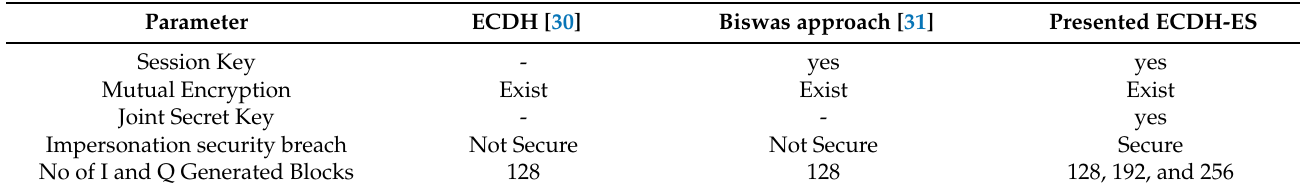
Table 3. Comparison of the proposed model with existing approaches in terms of